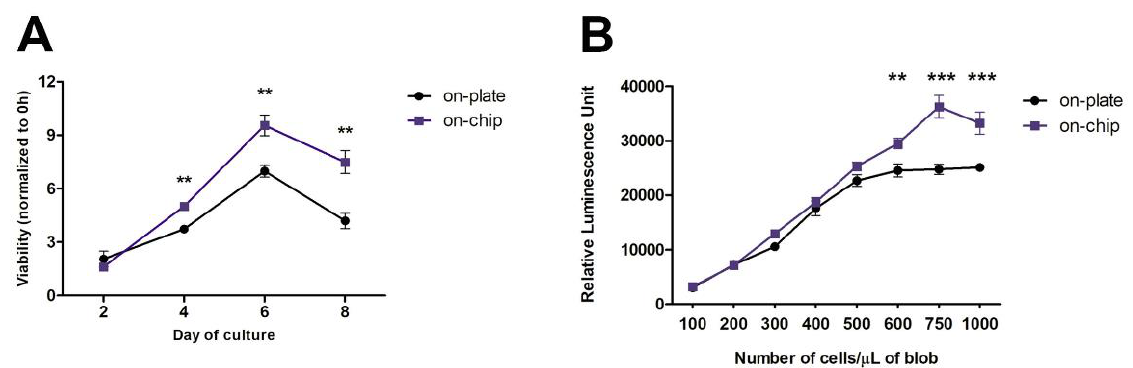
Figure 3. Optimization of Iso-50 organoids culture on-chip. ( A ) Viability of cultured organoids within OrganoidChip (on-chip) and on a traditional plate (on-plate). Viability was monitored at days 0, 2, 4, 6, and 8 using a CellTiter-Glo 3D Cell Viability Assay. The results are described as mean ± standard deviation (SD) of three independent experiments. The viability of the organoids at days 2, 4, 6, and 8 is expressed as the fold increase, compared with the viability at day 0, taken as 1 (Student’s t -test: ** p ≤ 0.01; *** p ≤ 0.001). ( B ) ATP measurement for proliferation in Iso-50 organoids after six days of culture at different cell seeding densities. Results are described as mean ± SD of three replicated wells (one independent experiment) for each cell density (Student’s t -test: ** p ≤ 0.01; *** p ≤ 0.001).